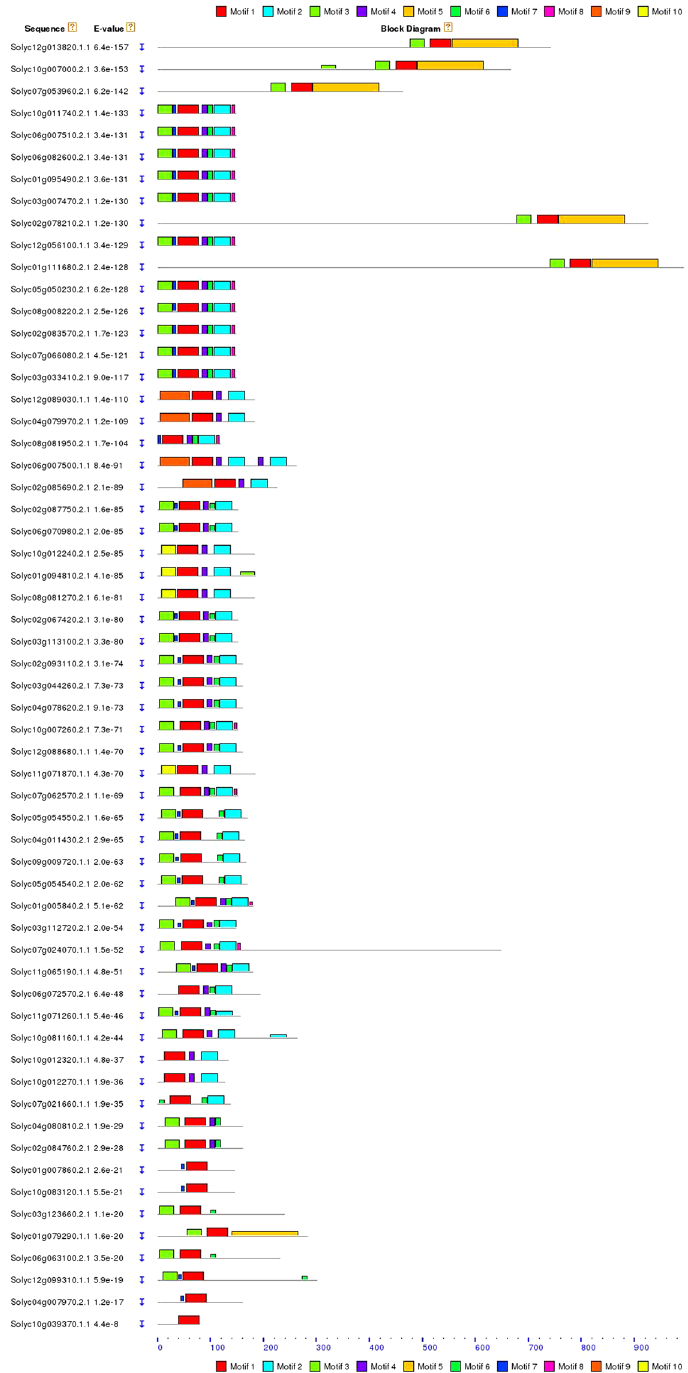
Figure 3. The discovered conserved motifs in all 59 sequences of tomato E2 enzymes are illustrated. A total of 10 motifs were discovered and their organization on the protein is represented by color